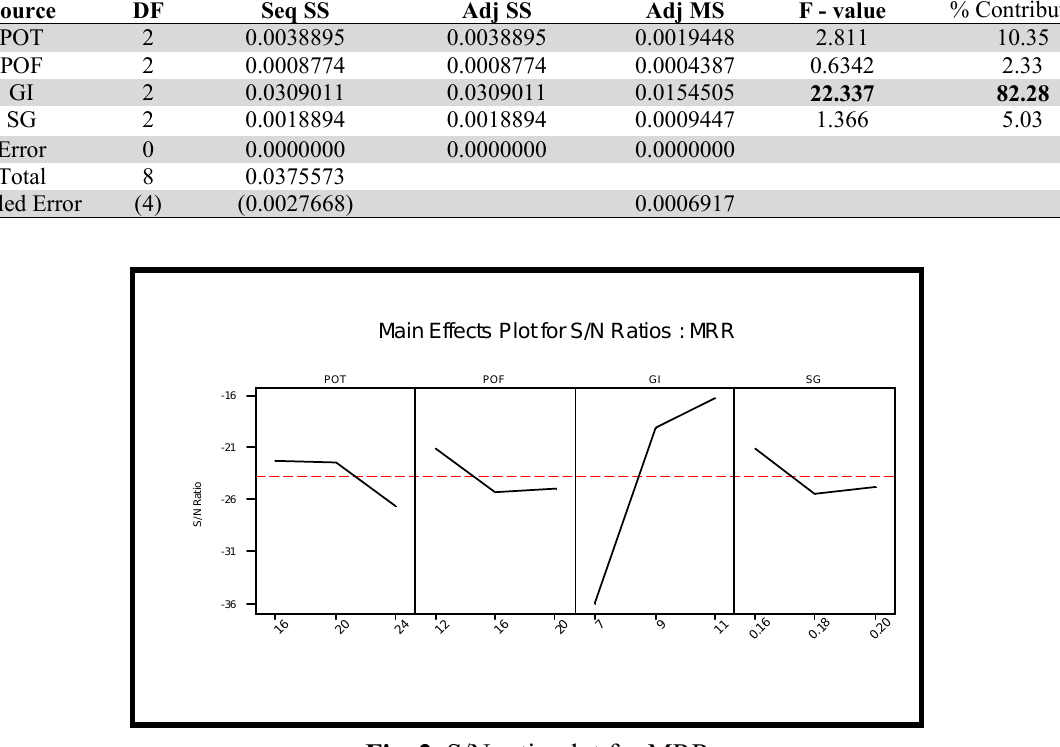
Fig. 2. S/N ratio plot for